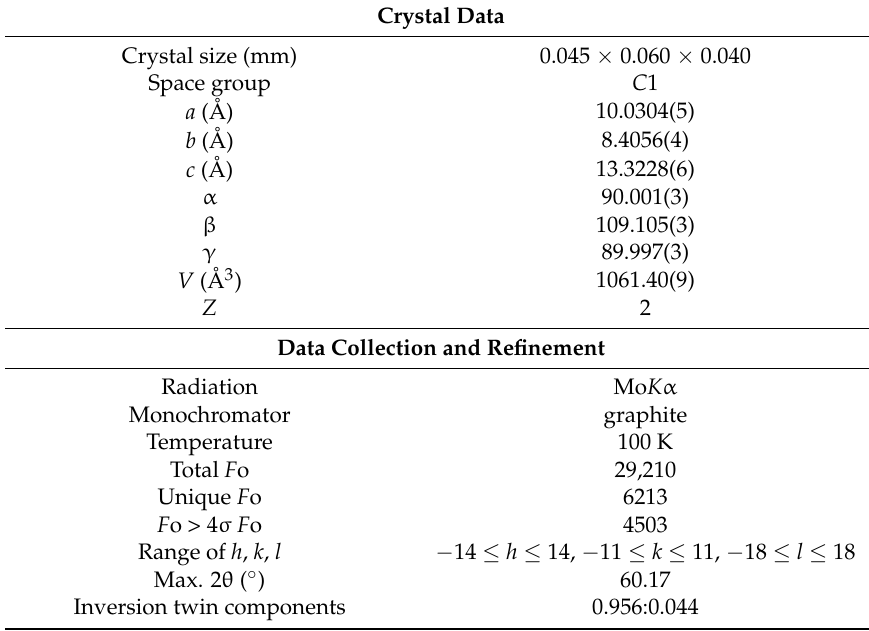
Table 2. Data measurement and refinement information for